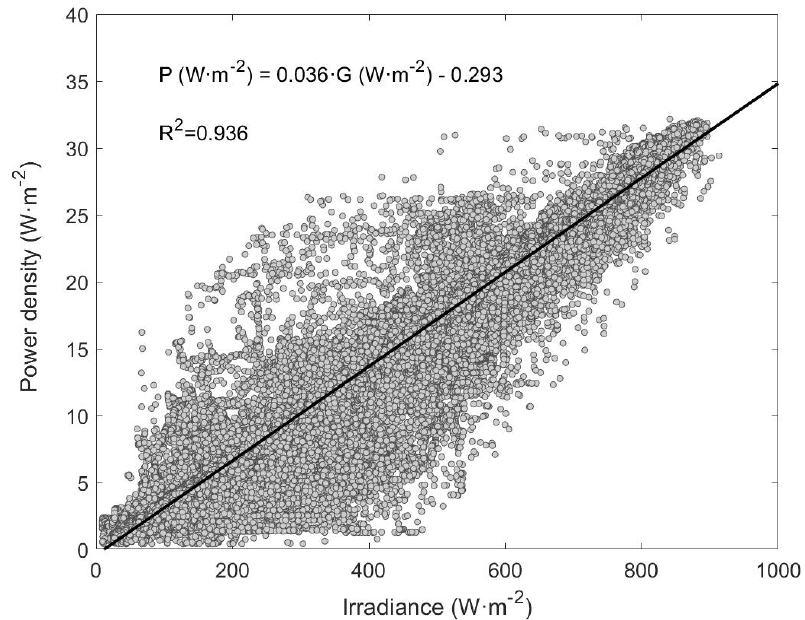
Figure 2. Experimental OPV power density as a function of irradiance. Table 4 . Summary of thermal characteristics.